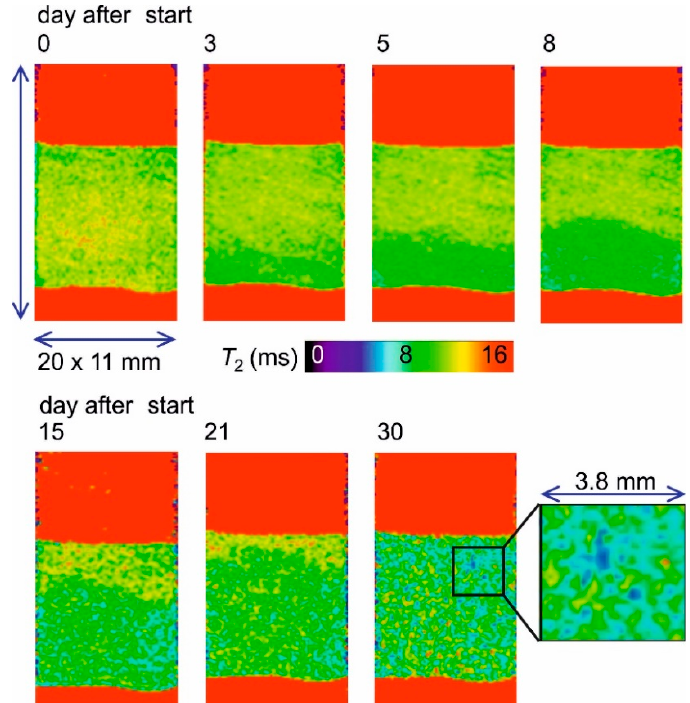
Figure 7. MRI T 2 relaxation time maps of a central vertical slice through the column. The reaction started on day 0 and the experiment was terminated on day 30. Flow is from bottom to top. Please note that the color in the sand packing below and above the celestine/barite zone is uniformly red due to overexposure in the selected color table. The excerpt on the right hand side in the bottom line shows exemplary patchy patterns of the barite precipitate. Resolution was 0.125 mm in-plane and the slice thickness was 0.9 mm.